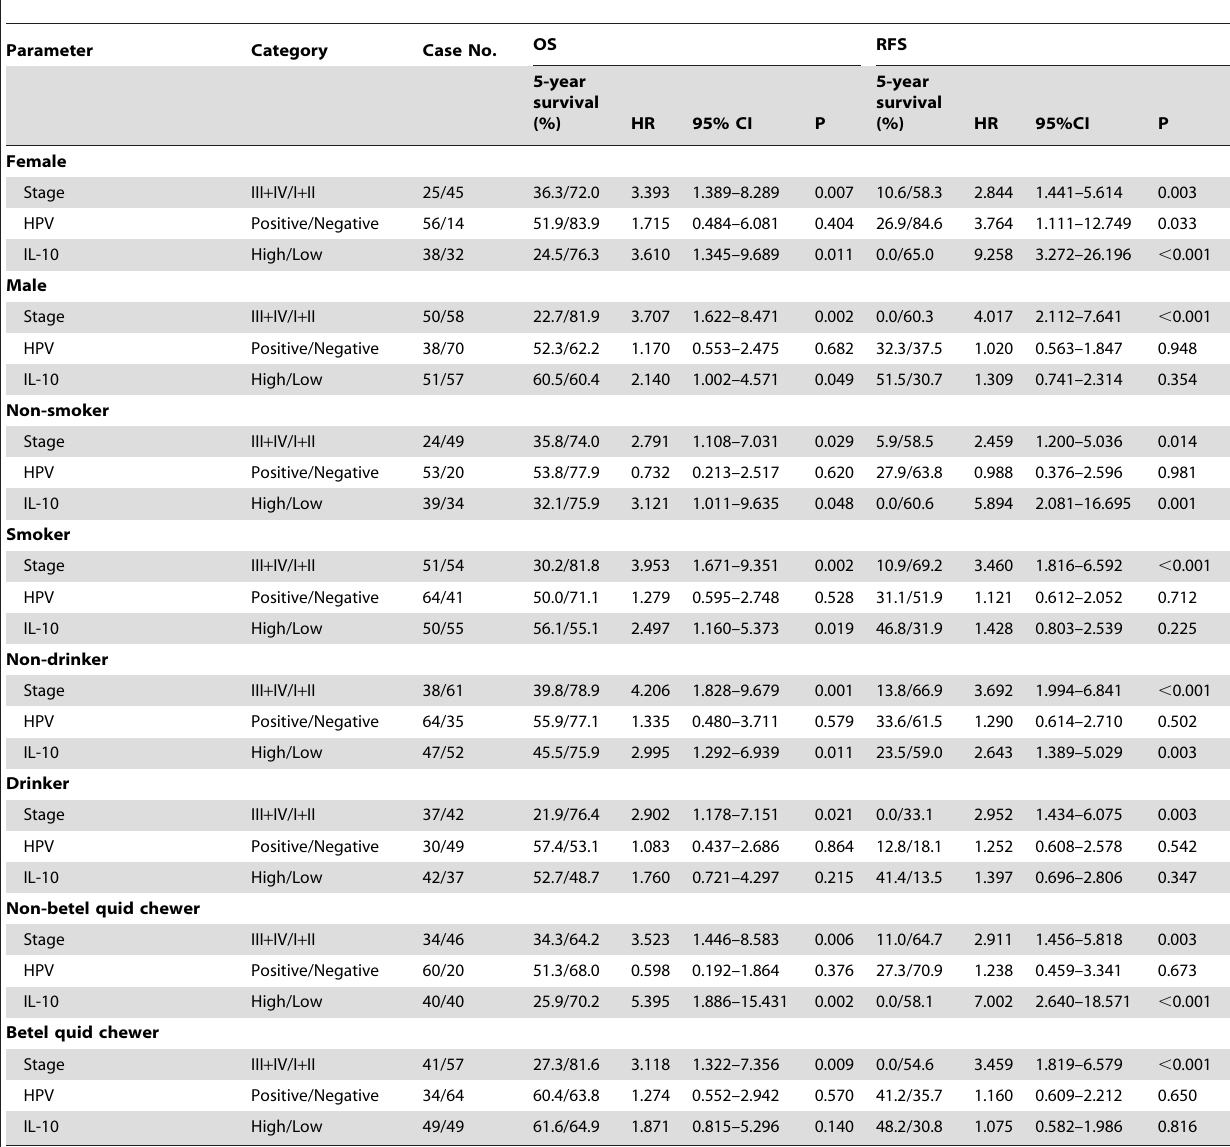
Table 4. Multivariate analysis of the influence of various parameters on overall survival (OS) and relapse free survival (RFS) in oral cancer patients according to